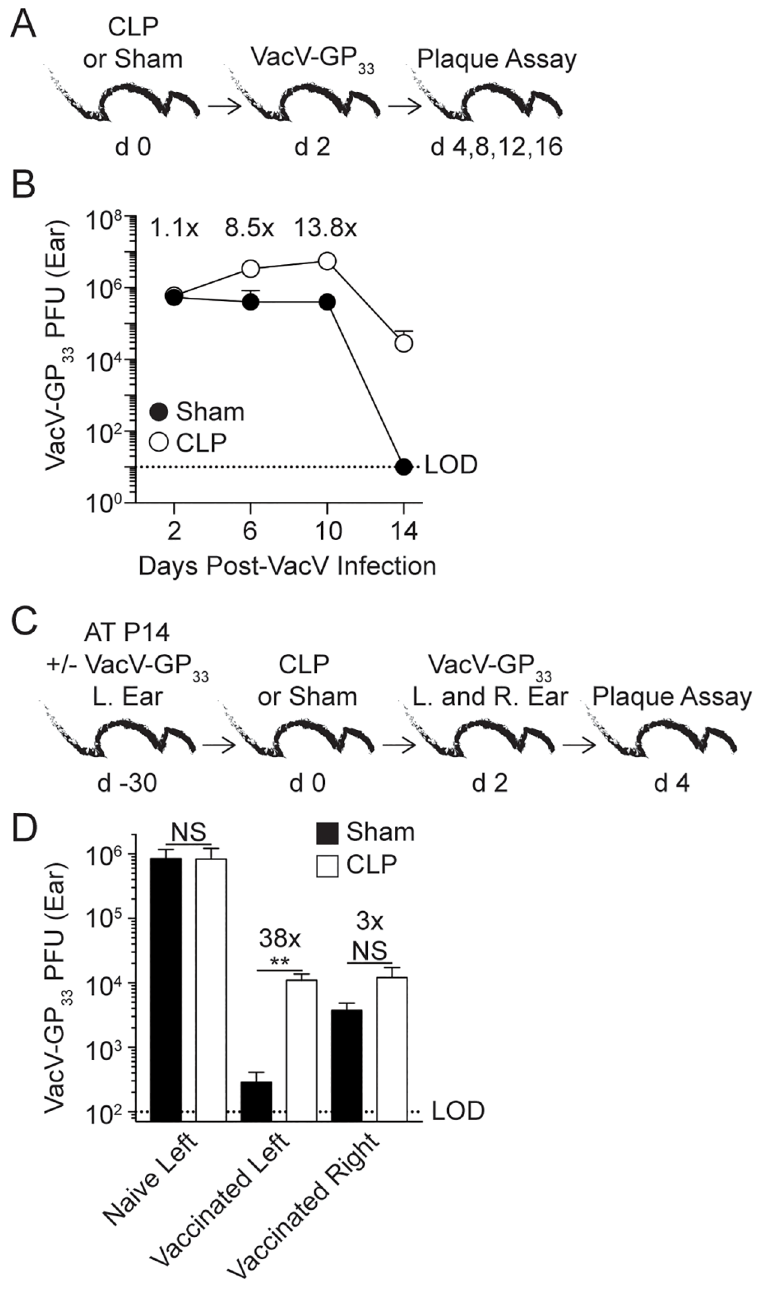
Fig 9. Protection to VacV re-challenge is diminished in VacV-immune mice after sepsis induction. (A) Experimental design.Naive hosts underwent CLP or sham surgery and two days later received VacV infection in the left ear and viral titer was determinedat varioustimes post infection. (B) Plaqueforming units (PFU) of the infected left ear of CLP or sham hosts after infection. Numbers above data points representthe fold changein PFUs. Dashedline representsthe LOD for the plaqueassay. (C) Experimental design. 10 4 naive P14 CD8 T cells (Thy1.1) were adoptively transferred into C57Bl/6 recipients (Thy1.2) that remainedna ï ve (non-vaccinated) or receivedVacV-GP 33 infectionof the left ear (vaccinated). After 30 days mice underwent CLP or sham surgery. The mice were then infected in left and right ears with VacV-GP 33 2 days later, followed by plaqueassay two days after infection. (D) PFU of the infected left ear of non-vaccinated and left and right ear of vaccinated animals 2 days after VacV-GP 33 infection. Data are representative of two similar experiments with 3–8 mice per group. Numbers abovebars show fold changein viral titer betweengroups. LOD = level of detection. NS = not significant; ** = p < 0.01.Error bars represent the standard error of the